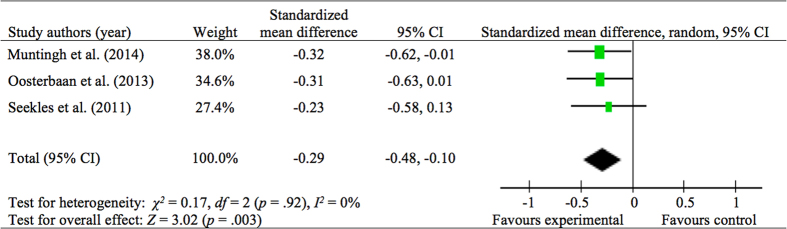
Stepped Care Treatment vs. CAU control on Anxiety Symptoms at Immediate Posttreatment.